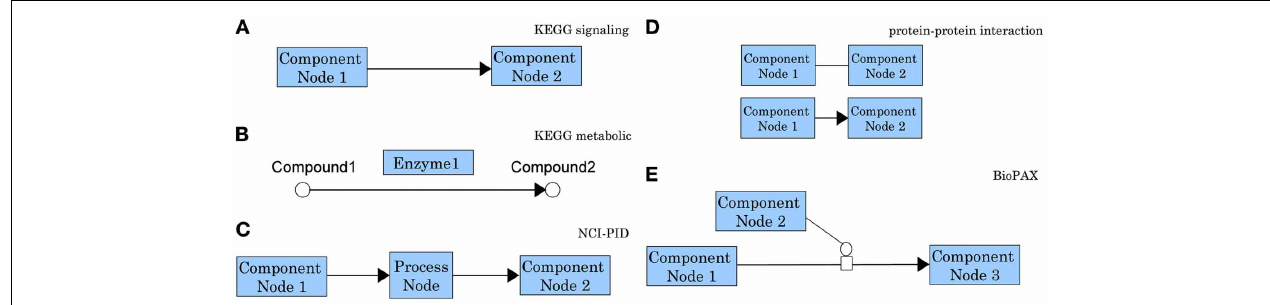
FIGURE 5 | Comparison of representative graph models for molecular interactions as used by different pathway databases. In a KEGG signaling pathway (A) nodes represent genes/gene products and edges represent regulatory signals such as activation, inhibition, phosphorylation, etc. (see http://www.genome.jp/kegg/document/help_pathway.html for details). In the chemical network representation of a KEGG metabolic pathway (B) the nodes represent biochemical compounds and edges represent chemical reactions. These chemical reactions are performed by enzymes which are proteins encoded by genes. Hence, in contrast with the signaling pathways in which genes are associated with nodes, in a metabolic pathways genes are associated with edges. This is the main reason most methods developed for signaling pathways cannot be applied directly to metabolic pathways. In an NCI-PID signaling pathway (C) nodes fall in two categories: component nodes representing biomolecular components, or process nodes representing biochemical reactions or biological processes. Edges connect two biomolecular components